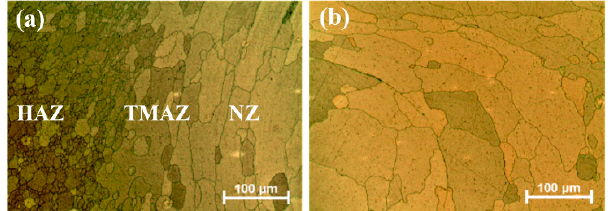
Figure 12. Microstructure around ( a ) and within ( b ) the nugget zone of the welded sample after W + T6 heat.